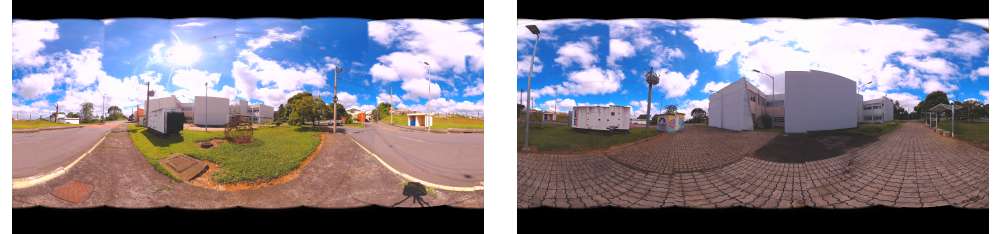
Figure 4. Arts and Design School at the Federal University of Juiz de Fora: Two point of